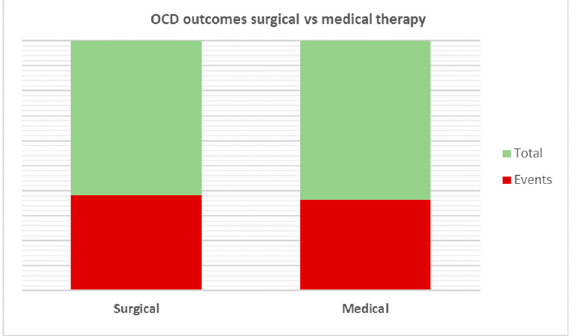
Figure 4. Comparative analysis of OCD outcomes after treatment. No statistical significance was reached among the two therapies analyzed ( p = 0.65).